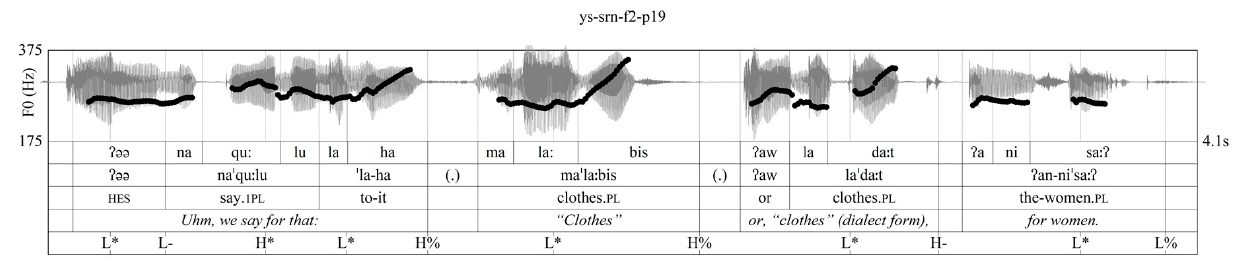
Figure 7. An F-coded turn with continuation rises and a broadcast MSA-style final short phrase.